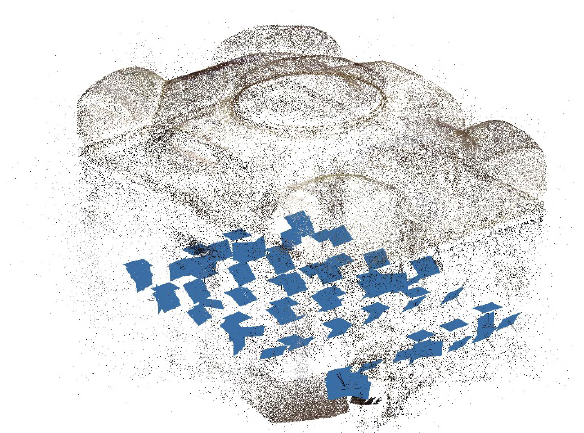
Figure 7. Sparse point cloud with aligned cameras from PhotoScan - ‘Prima Anticamera’ (Modelling: F. Natta)